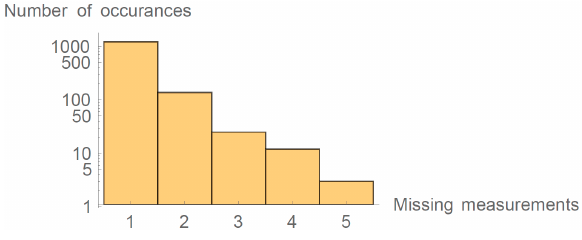
Figure 3. Missing detections of AP4 at AP2.